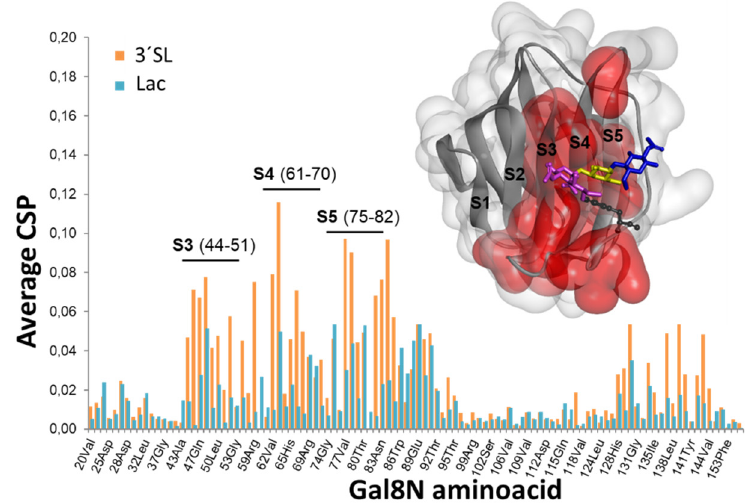
Figure 2. CSP plot measured for the interaction of Gal8N with lactose (in blue) and 3 ′ SL (in orange) upon protein saturation for the 20 and 1.5 molar ratio complexes, respectively. The molecular model corresponds to the X-ray crystallographic structure of Gal8N/3 ′ SLN (pdb 3vko), where the residues affected in the presence of 3 ′ SL and not with lactose are highlighted in red. 3 ′ SLN is represented as sticks with Neu5Ac in magenta, Gal in yellow, and GlcNAc in blue. The key W86 is represented in black as ball and sticks.